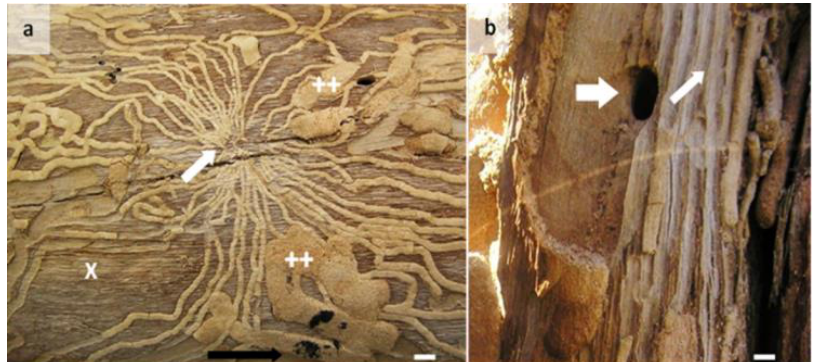
Figure 4. Photos of an example of galleries in surface sapwood of marri ( Corymbia calophylla ) infested